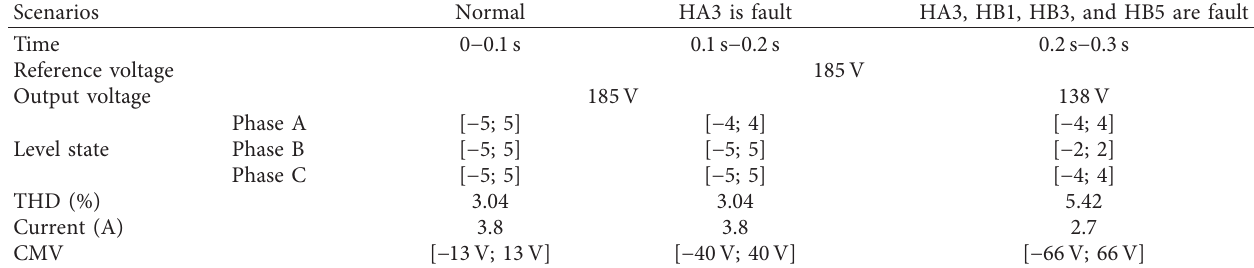
Table 7: Simulation results.